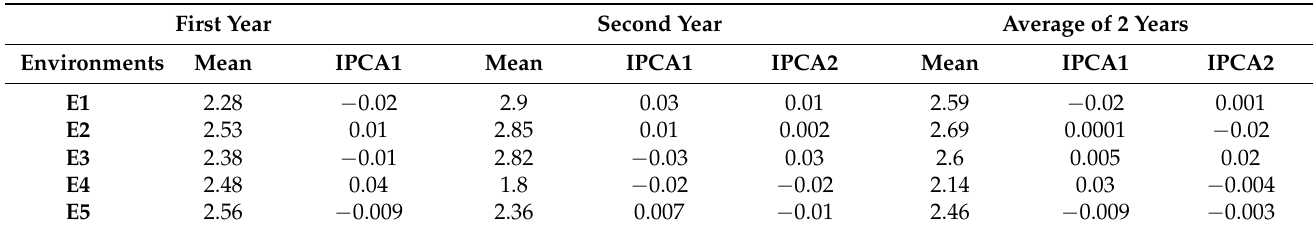
Table 4. Average value, first principal component and second principal component in the five studied areas in the first, second and average of two crop years.